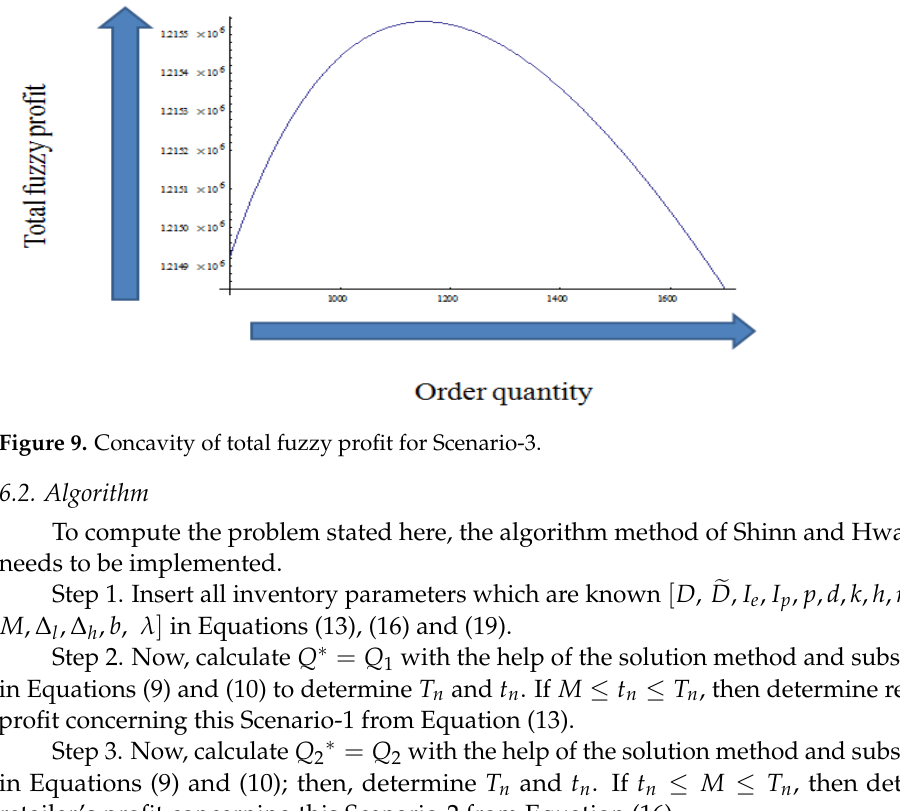
Figure 8. Concavity of total fuzzy profit for Scenario-2.